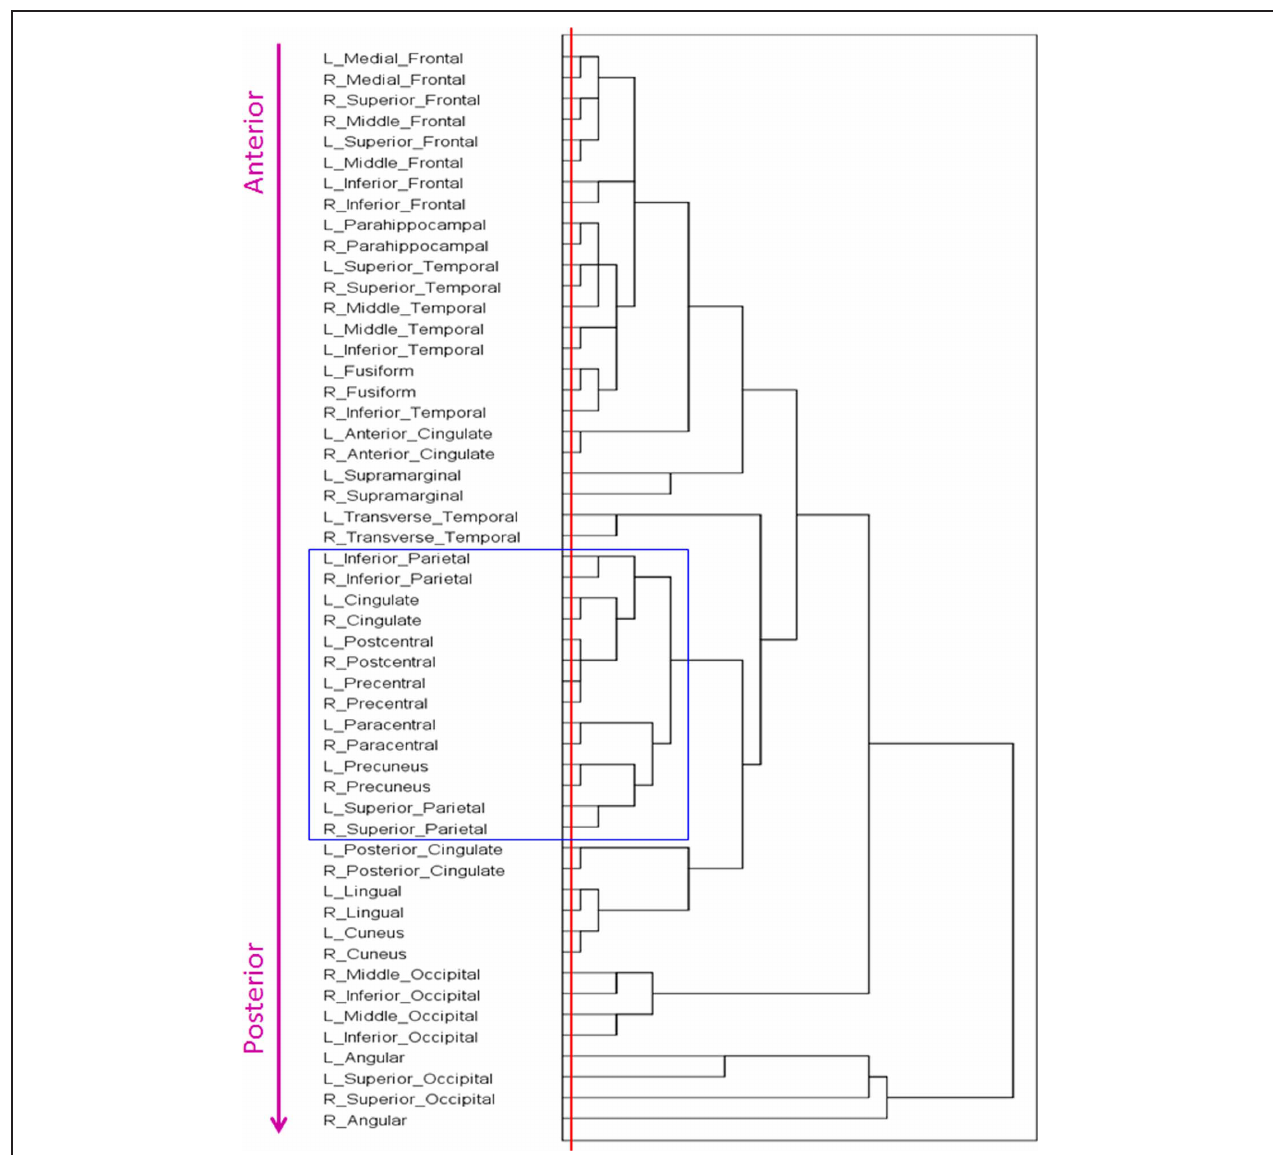
FIGURE 1 | Dendrogram derived by hierarchical tree clustering of 52 cortical areas (see text for details).